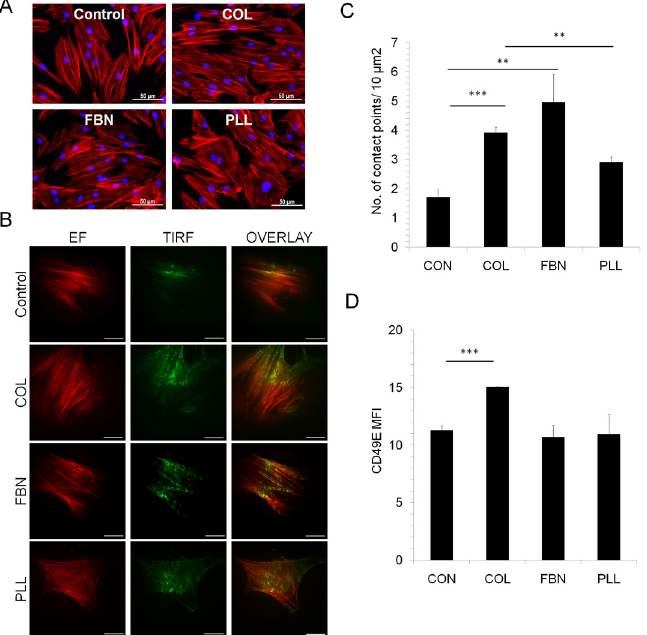
Fig 2. Actin cytoskeleton and cell-surface contact points of MSC. (A) MSC seeded on uncoated surface (Control), COL, FBN and PLL matrices were stained with TRITC conjugated phalloidin to visualize F-actin (red) and nucleus was stained with DAPI (blue). (B, C) The cell-contact points of MSC with different substrates was analysed by total internal reflection fluorescence microscopy (TIRF) in cells stained with phalloidin-TRITC cultured on glass coverslips. Representative images are shown; the scale bars represent 20 μ m. EF- Epi fluorescence. (D) The expression levels of CD49e in MSC cultured on TC surface (CON), COL, FBN and PLL surfaces were analysed by flow cytometry. The mean fluorescence intensity (MFI) for each sample was calculated based on their respective isotype control. Values are Mean ± SD, n = 5 samples. ** p < 0.005, *** p <